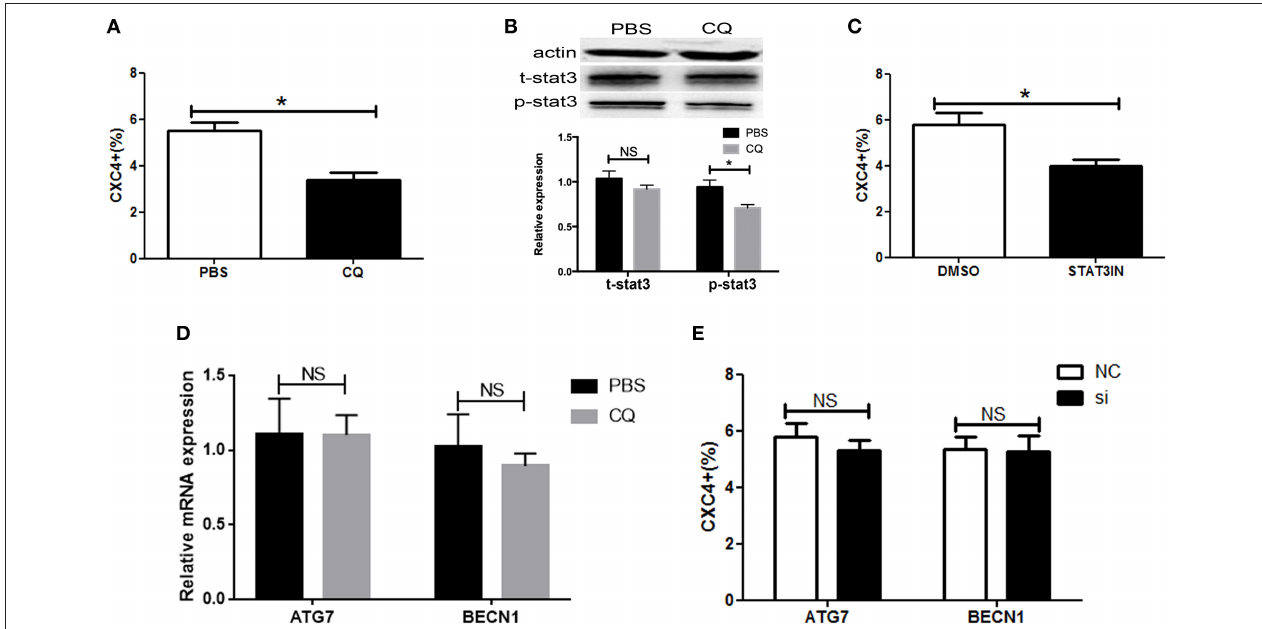
FIGURE 5 | Chloroquine targeted CXCR4-positive ESCC cells via STAT3. (A) The expression of CXCR4 was analyzed by flow cytometry. (B) The activity of pSTAT3 and tSTAT3 were measured by western blotting in ESCC cells with or without CQ treatment (5 µ M). (C) The expression of CXCR4 was analyzed by flow cytometry in